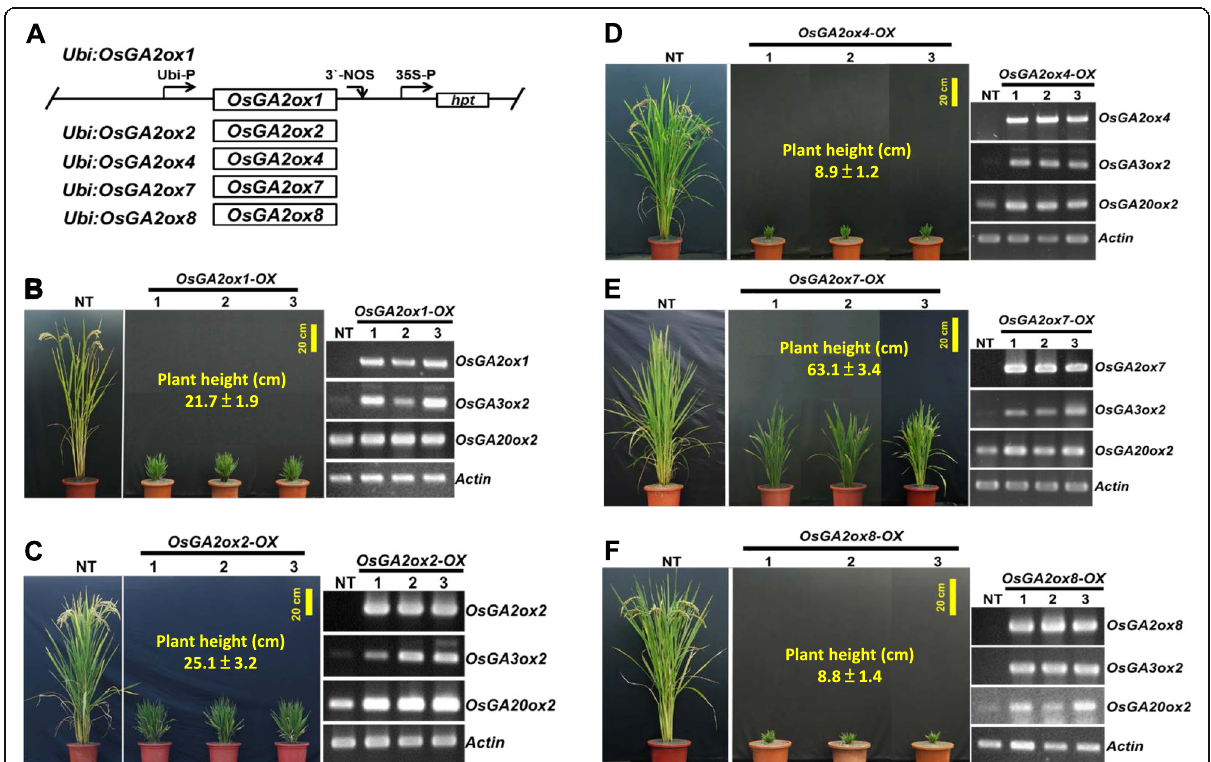
Fig. 3 Phenotypic comparisons and characterization of OsGA2ox1 , 2 , 4 , 7 , and 8 expressions in overexpression transgenic rice plants . a Schematic diagram showing the overexpression constructs of Ubi:OsGA2ox1 , Ubi:OsGA2ox2 , Ubi:OsGA2ox4 , Ubi:OsGA2ox7 , and Ubi:OsGA2ox8. The full-length cDNA from each gene was cloned into the same vector construct. Three representative T 0 transgenic plants from each of the OsGA2ox1-OX ( b ), OsGA2ox2-OX ( c ), OsGA2ox4-OX ( d ), OsGA2ox7-OX ( e ), and OsGA2ox8-OX ( f ) transgenic lines were compared to their nontransgenic (NT) plants. The average plant height in cm (means ± SE, n ≧ 10) for each gene constructs are shown. RT-PCR was performed to analyze the respective target genes and marker genes of OsGA3ox2 and OsGA20ox2 , and the Actin gene (as an internal control) is